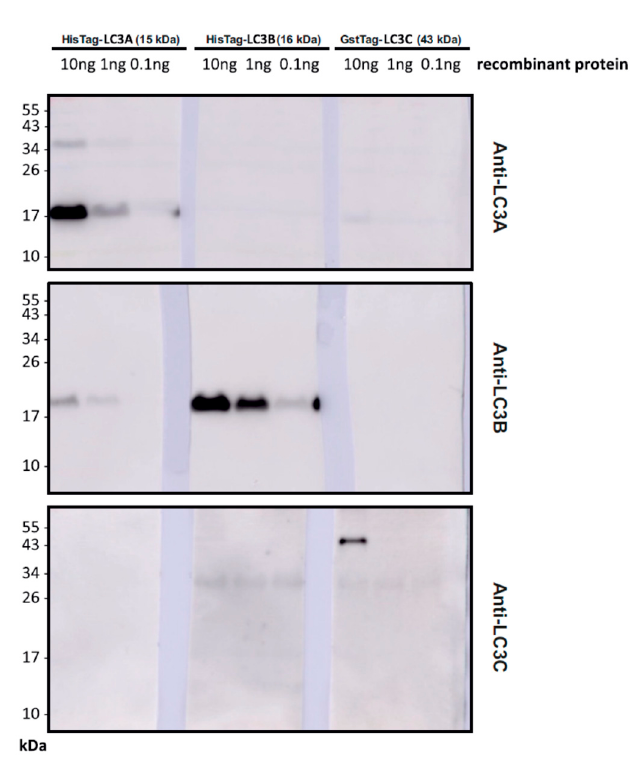
Figure 2. Western blot analysis of anti-LC3 antibody specificity. Each framed box represents three membrane pieces (LC3A / LC3B / LC3C) that were developed with the indicated antibody (right margin) simultaneously. Membrane pieces for each LC3 had been cut from the same master membrane loaded several times with only one of the LC3s to assure equal transfer efficiency. The loaded amount per lane and the expected size (in kDa) are indicated. The employed antibodies were: anti-LC3A from Cell Signaling (#4599), anti-LC3B from Sigma (#L7543), anti-LC3C from Abcam (#ab150367).